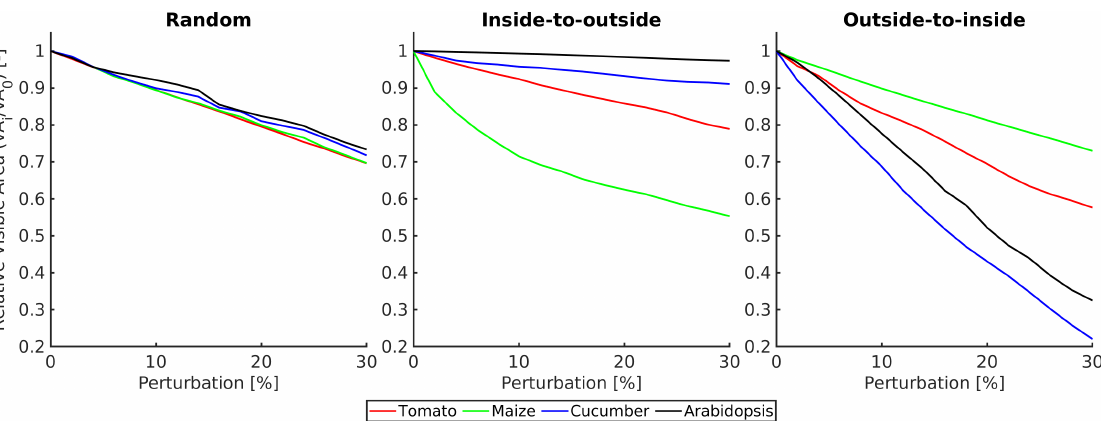
Figure 10. Visualization of the relative visible area for each perturbation scenario in different plant